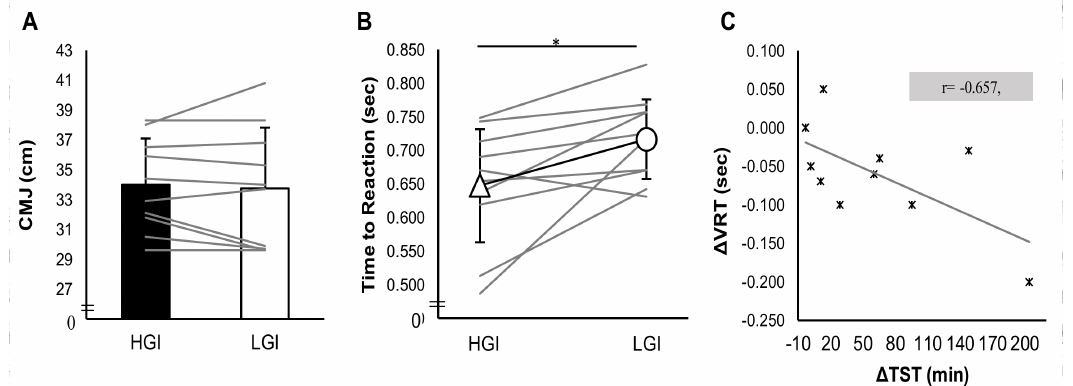
Figure 3. Exercise performance in ( A ) countermovement jump test; ( B ) visual reaction test, between trials, and ( C ) the correlation of the difference between HGI and LGI total sleep time with the difference between the HGI and LGI visual reaction test. * Denotes statistical significant differences at the 0.05 level